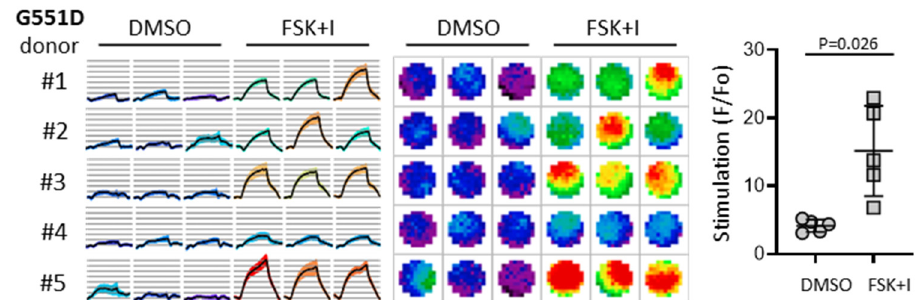
Figure 3. FMP plate reader studies of responses to forskolin plus ivacaftor on nasal cultures from 5 donors possessing G551D on one or both alleles. The traces on the left show reproducible responses to forskolin plus ivacaftor (I). The coloured regions in the traces are +/ − 1 SD of the mean at each time point. The mean is indicated as the black tracing. The traces are colour-coded according to the magnitude of the response. The dots in the left-middle panel represent a different visualization, with each dot showing a well scan of FMP, coloured according to magnitude. On the right , the mean FMP responses for the five donors are shown. There was significant augmentation of the functional expression following acute treatment with FSK+I, as determined using Student’s paired “ t ” test.